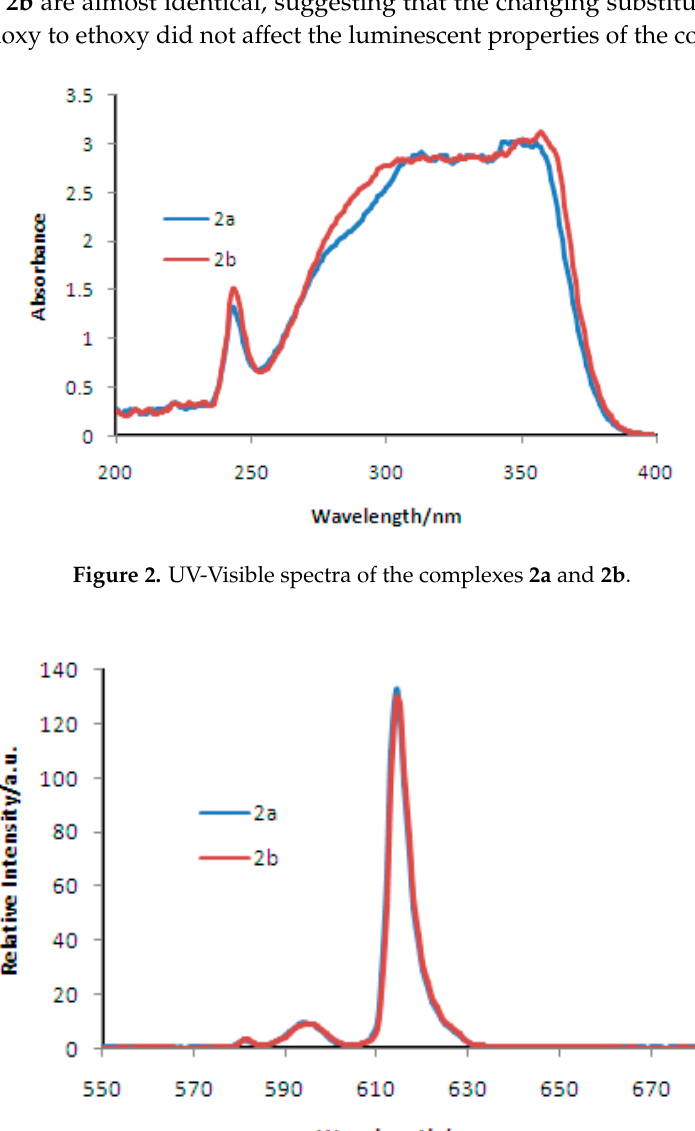
Figure 3. Emission spectra of the complexes 2a and 2b .